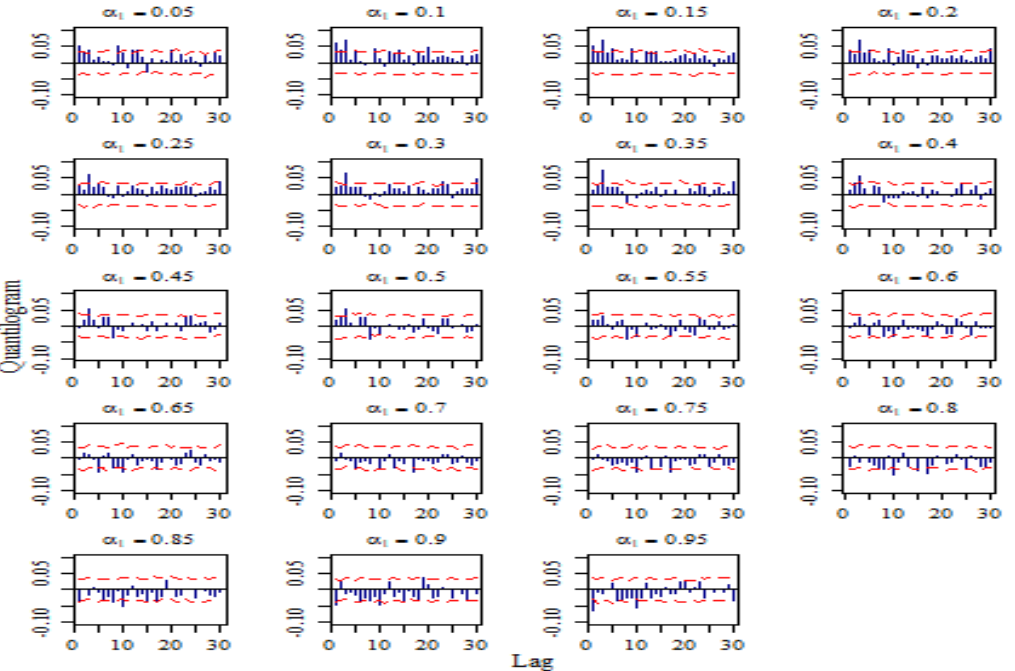
for 𝑞𝑞 2 ( 𝛼𝛼 2 ) 𝛼𝛼 2 =